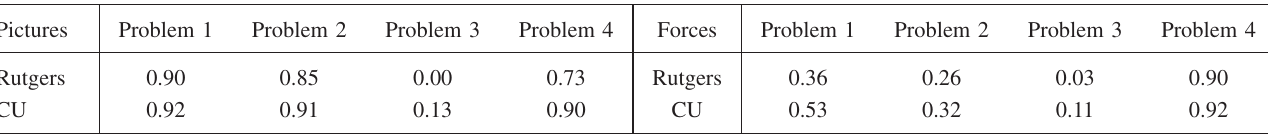
TABLE II. Fraction of students drawing a picture for each of the four recitation problems, and fraction of students identifying any forces correctly in their solution. Standard errors vary but are on the order of